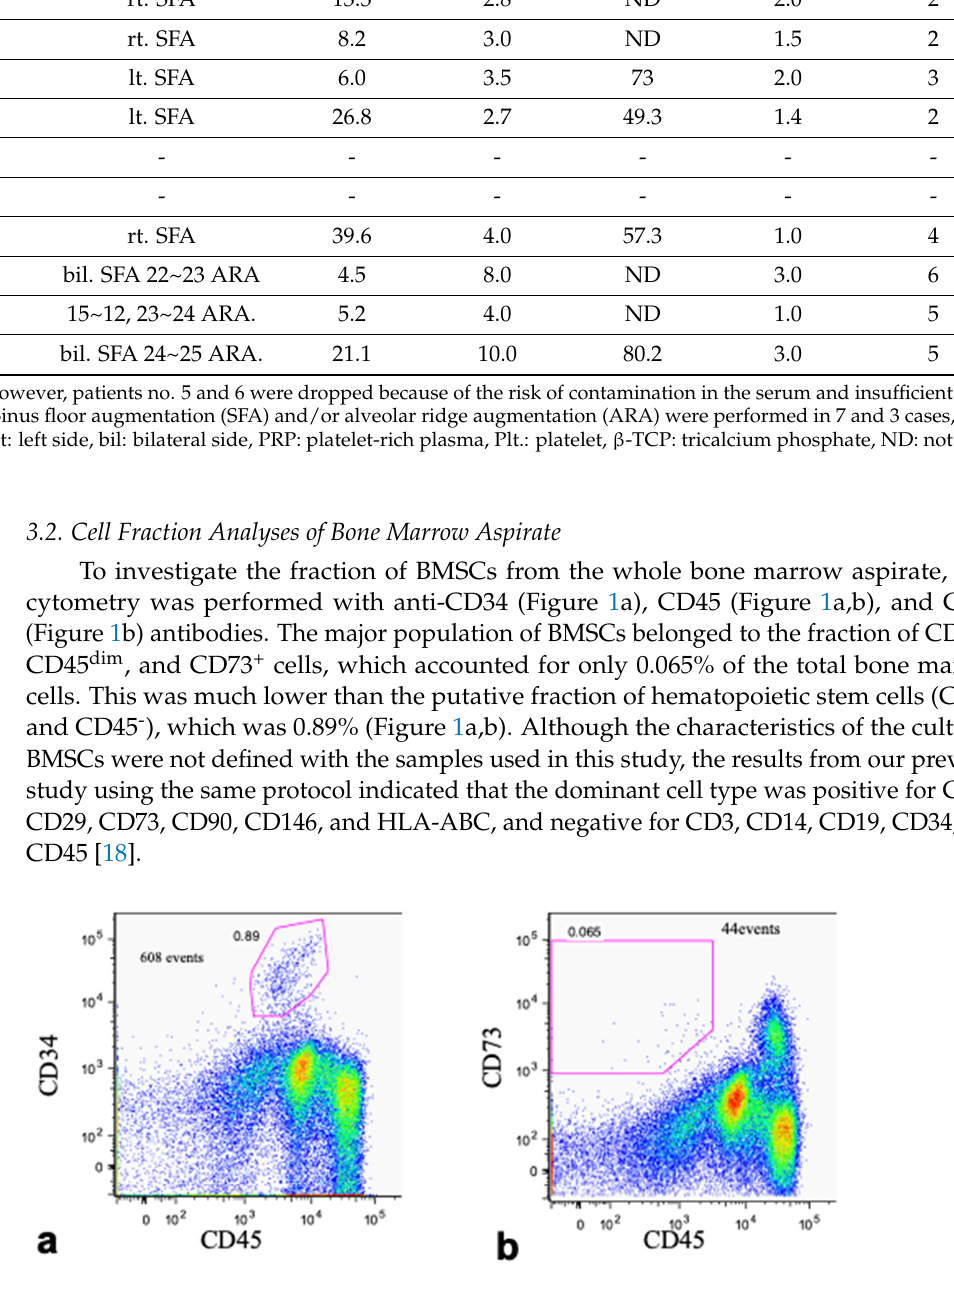
Figure 1. Flow cytometry of harvested whole bone marrow cells. The cells were sorted ( a ) with anti-CD34 and CD45 and ( b ) with anti-CD73 and CD45.